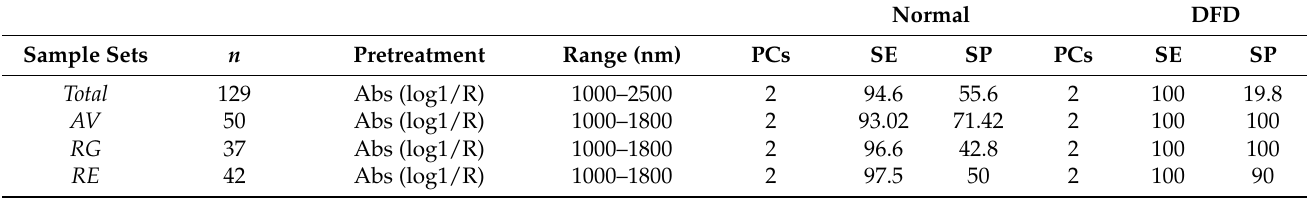
Table 3. Results of SIMCA analysis of NIR spectra data after absorbance (log 1/R) in cross-validation for both categories of beef (Normal vs. DFD) in Total, AV, RG, and RE sample sets. Normal DFD Sample